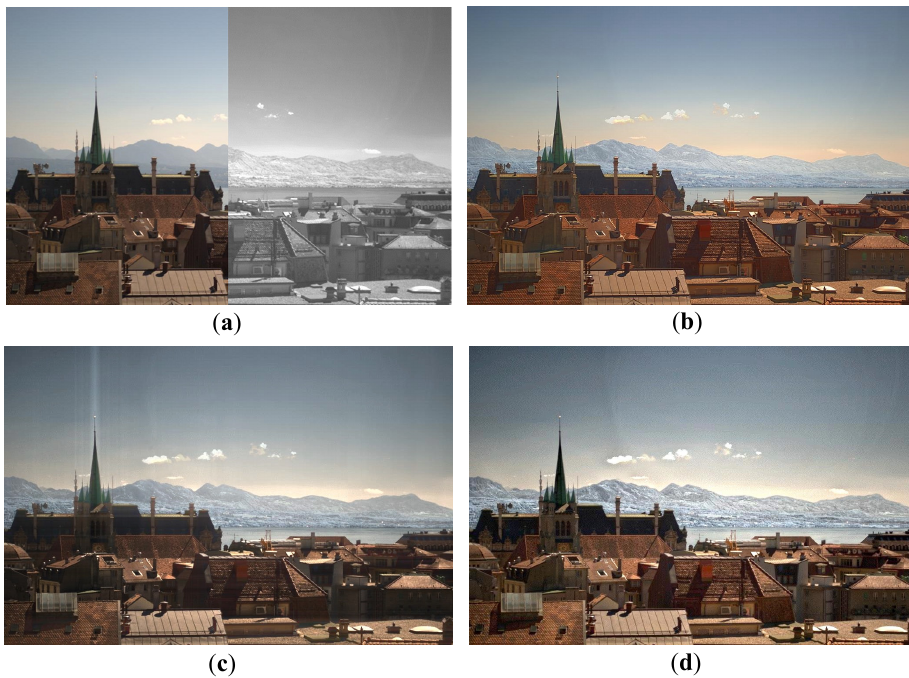
Figure 9. Input image pair and resulting images: ( a ) input VIS and NIR images, ( b ) Laplacian pyramid fusion [1], ( c ) low-rank fusion [5], and ( d ) the proposed method.